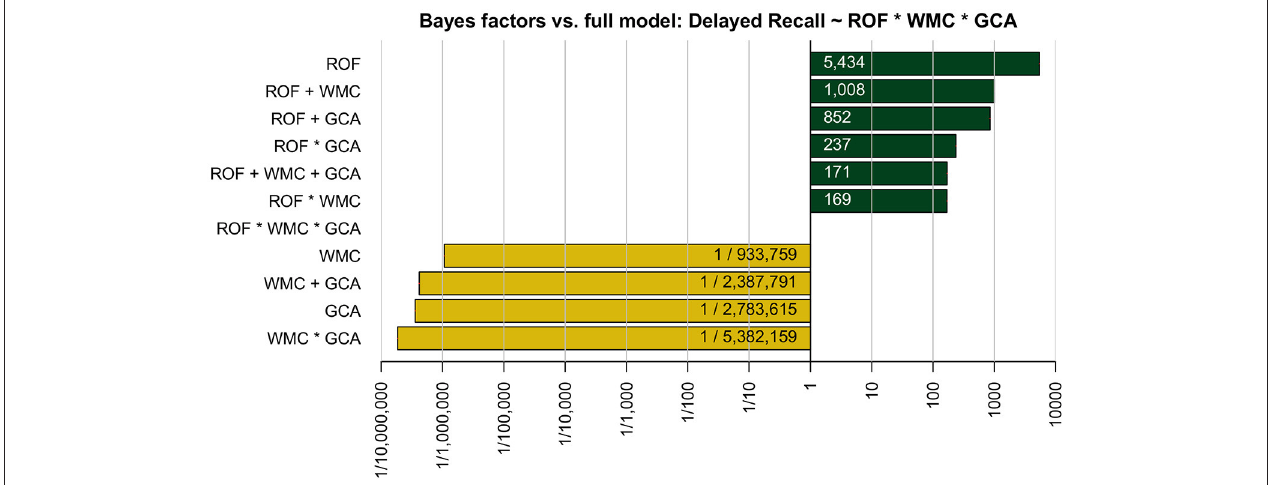
FIGURE 3 | The Bayes factor (x-axis) for each model (y-axis) relative to the full model including the three constructs and all their interactions. In the model names on the y-axis, a “ + ” denotes that only main effects for the listed variables are included and an “*” denotes that both main and interaction effects are included. The variables abbreviations are ROF, rate of forgetting; WMC, working memory capacity; and GCA, general cognitive ability. The dependent variable in all models is the delayed recall performance 3 days